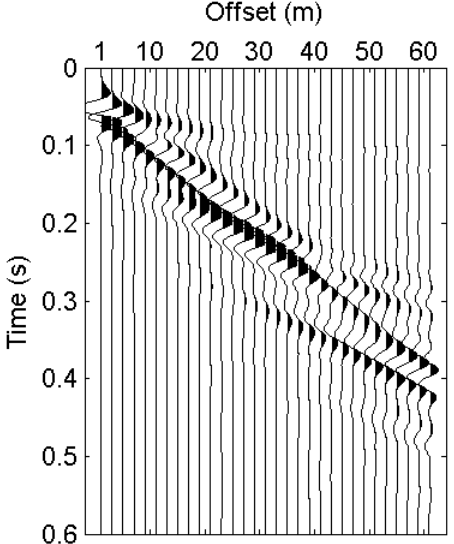
Table 2. The parameters of Model 2.